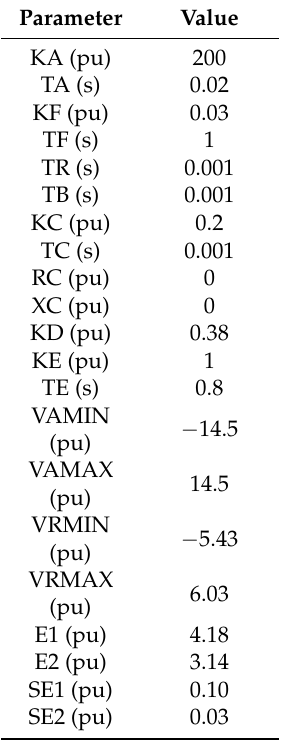
Table A2. Parameters of exciter type AC1A.